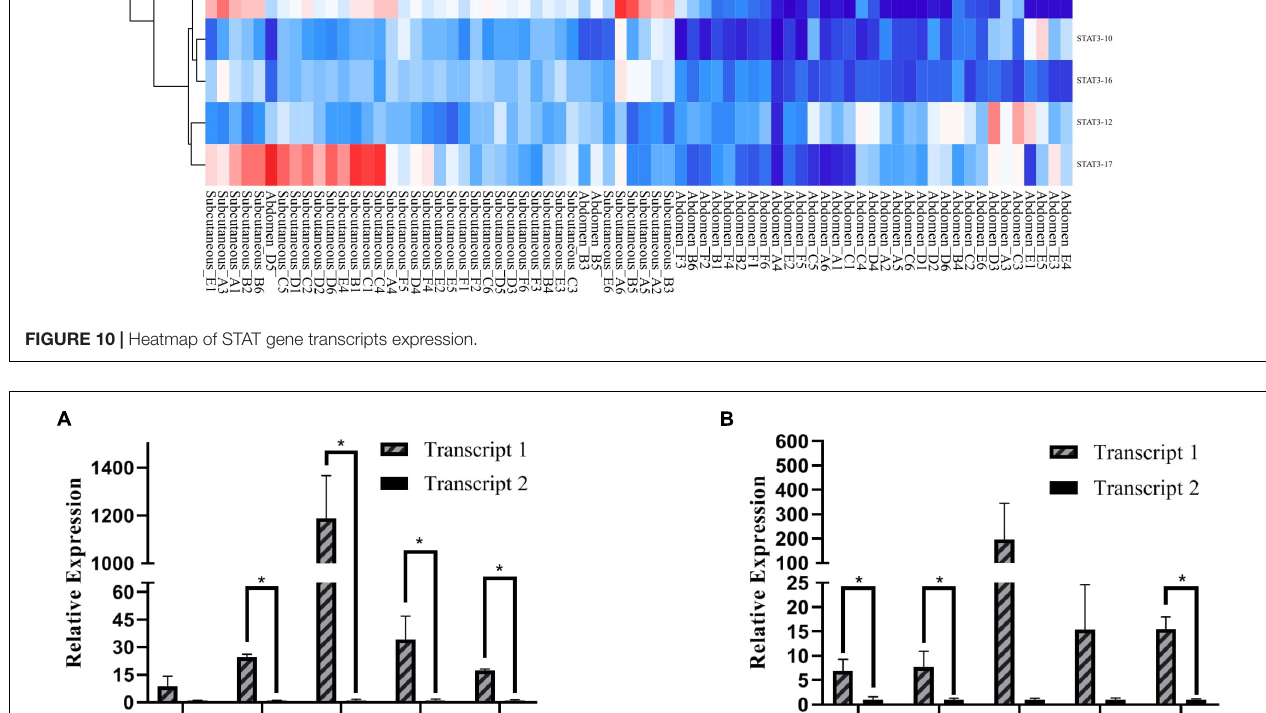
different transcripts of the same gene is also different.